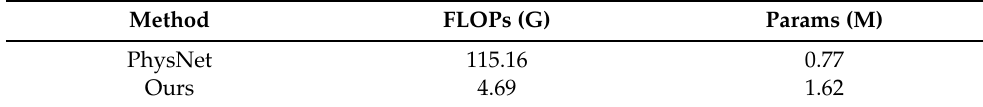
Figure 17. The analysis of the correlation plot ( left ) and the Bland–Altman plot ( right ) of frequency- domain metrics of HRV on the PURE dataset. ( top ) is LF, ( middle ) is HF, ( bottom ) is LF/HF. Table 6. Comparison of FLOPs and parameters based on 3DCNN